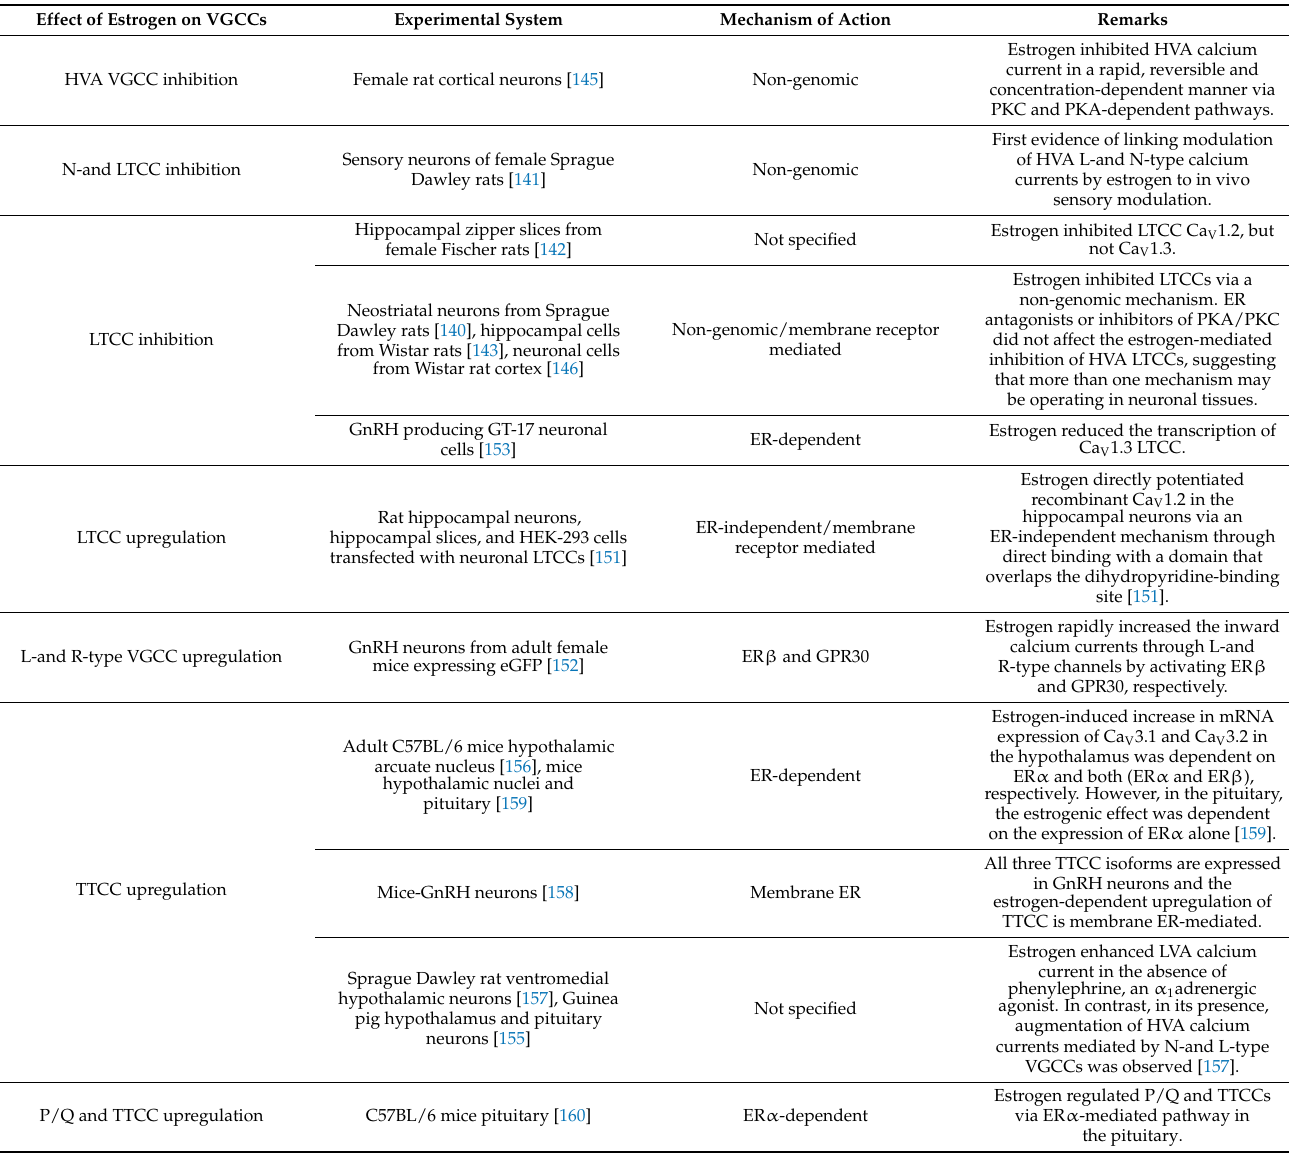
Table 3. Estrogenic modulation of VGCCs in neuronal tissues in physiological